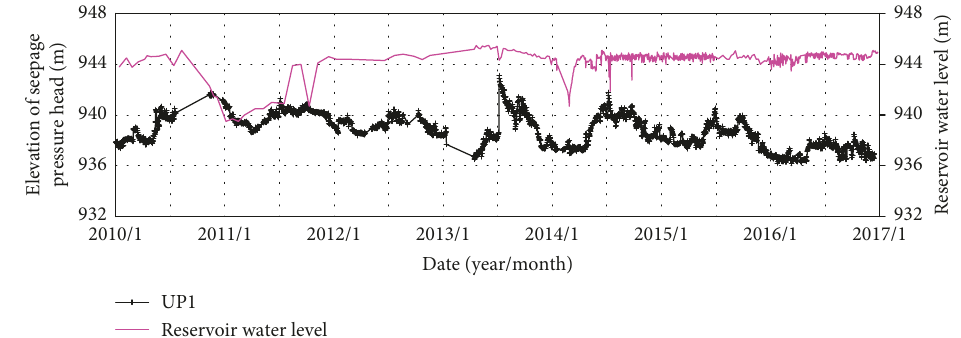
Figure 5: Time series for seepage pressure head at UP1 and reservoir water